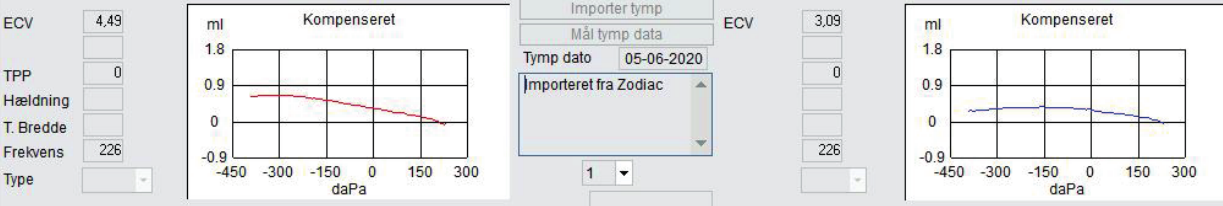
Figure 3. Hearing test after 3 months of treatment with Dupilumab. X-axis: sound level in decibel, Y-axis: frequency in Hertz. SRT: Speech Recognition Threshold, DS: Discrimination Score o-o: air conduction right ear, x-x: air conduction left ear.